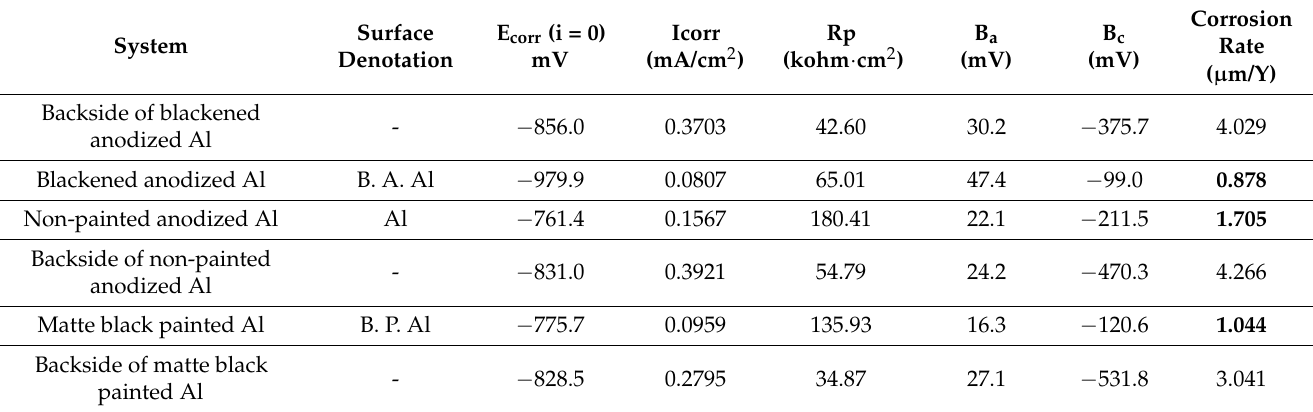
Table 2. Corrosion parameters for different aluminum surfaces in 3.5% NaCl solution at room temperature, extracted from the Tafel plot.